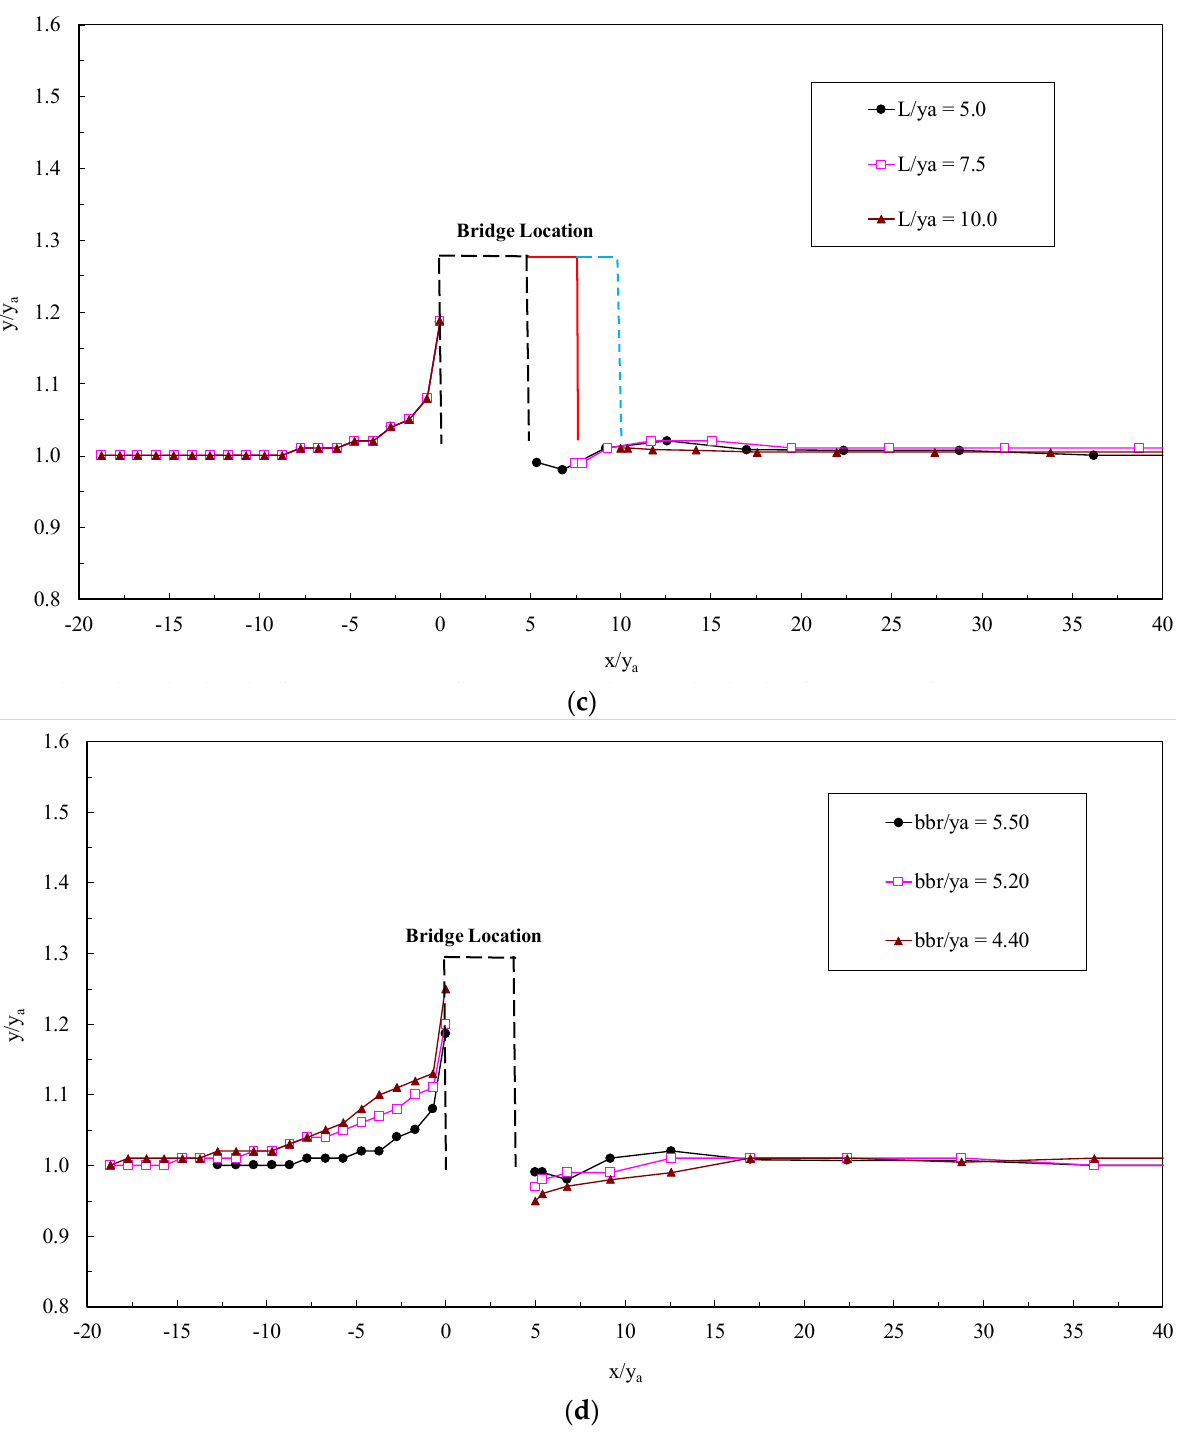
Figure 5. Relative flow depth y / y a in the nondimensional streamwise distance x/y a : ( a ) for different relative bridge openings y b / y a and F a* = 0.236 ; ( b ) for different densimetric Froude numbers and y b /y a = 0.55 ; ( c ) for different relative bridge lengths L/y a and y b /y a = 0.55 ; and ( d ) for different relative bridge widths b br / y a and y b /y a = 0.55.